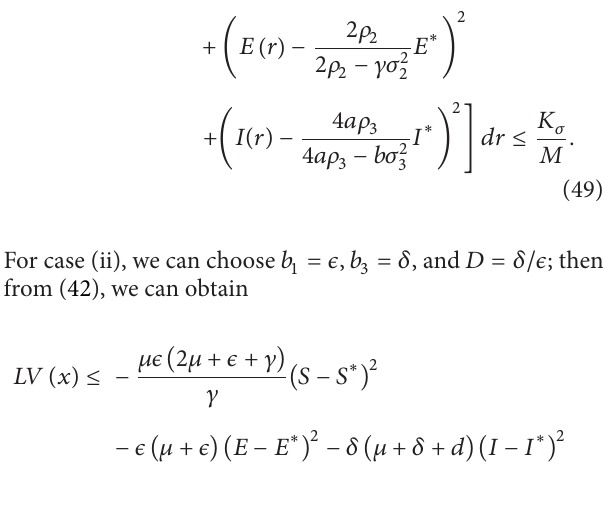
= 0.01 , 𝜎 = 0.02 , and 𝜎 = 0.01 1 2 3